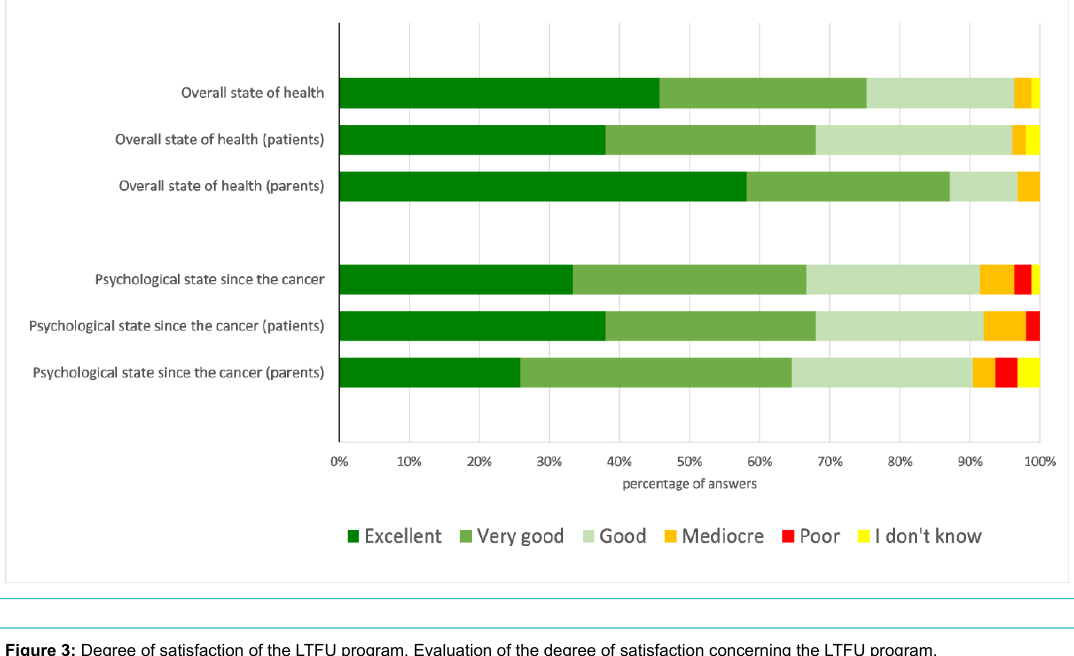
Figure 2: Perception of patient health and psychological status by the patient and/or by parents.